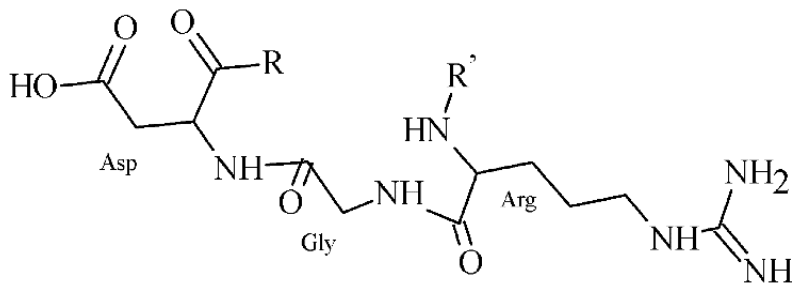
Figure 16. Structure of a peptide containing RGD sequence. Table 11. Summary of radiolabeled RGD analogues for α v β 3 receptor-positive tumor imaging over past 3 years. Composition of Studied